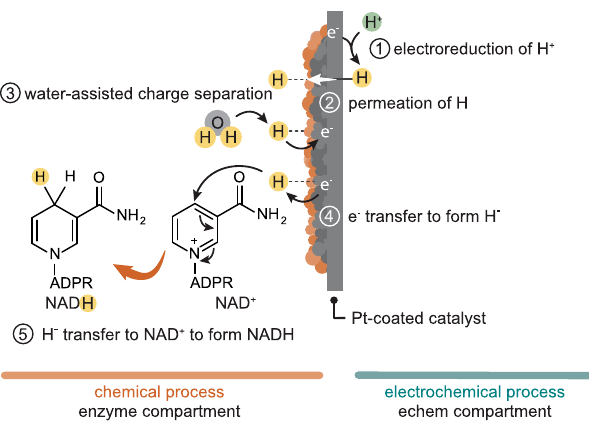
Fig. 7 | Proposed water-assisted NADH formation mechanism. (1) Protons are reduced at the Pd foil to form atomic hydrogen; (2) atomic hydrogen permeates through the Pd foil to form surface-boundhydrogen; (3) surface-bound hydrogen undergoes water-assisted charge separation, producing hydronium and a reduced metal surface; (4) electron transfer from the reduced metal to surface-bound hydrogen forms hydride; (5) hydride transfers to NAD + , forming